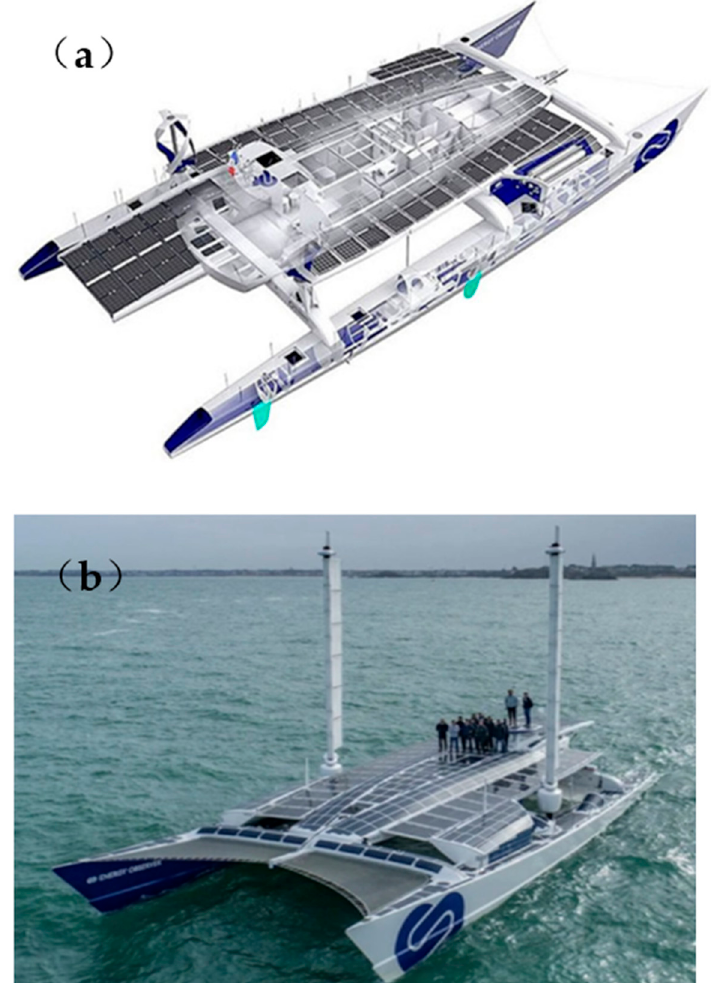
Figure 15. ( a ) The conceptual design of “Energy Observer” [89]; ( b ) the real ship “Energy Observer” [89].